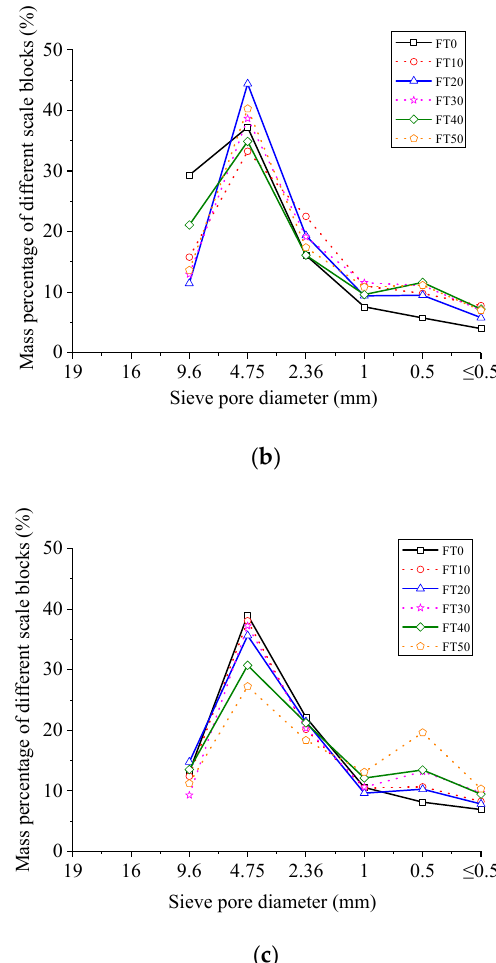
Figure 5. Scale–mass distribution law of concrete fragments. ( a ) 5.4 m/s; ( b ) 8.8 m/s; ( c ) 11.3 m/s.